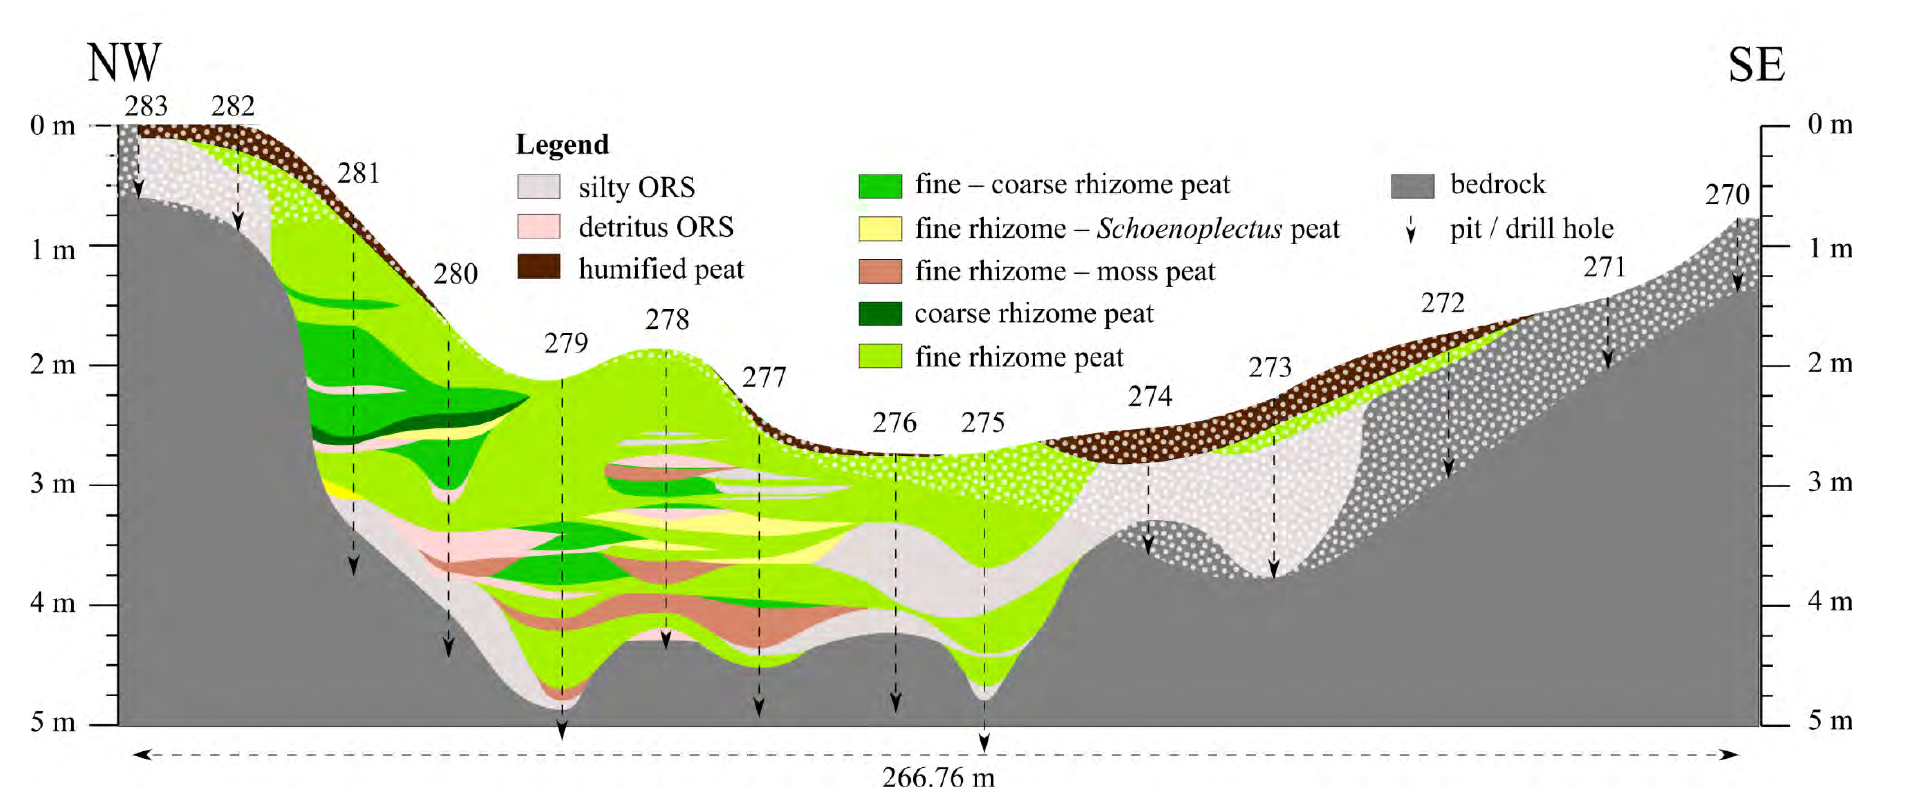
Figure 6. Stratification of the At-Bašy Peatland. White dots mark layers which contain